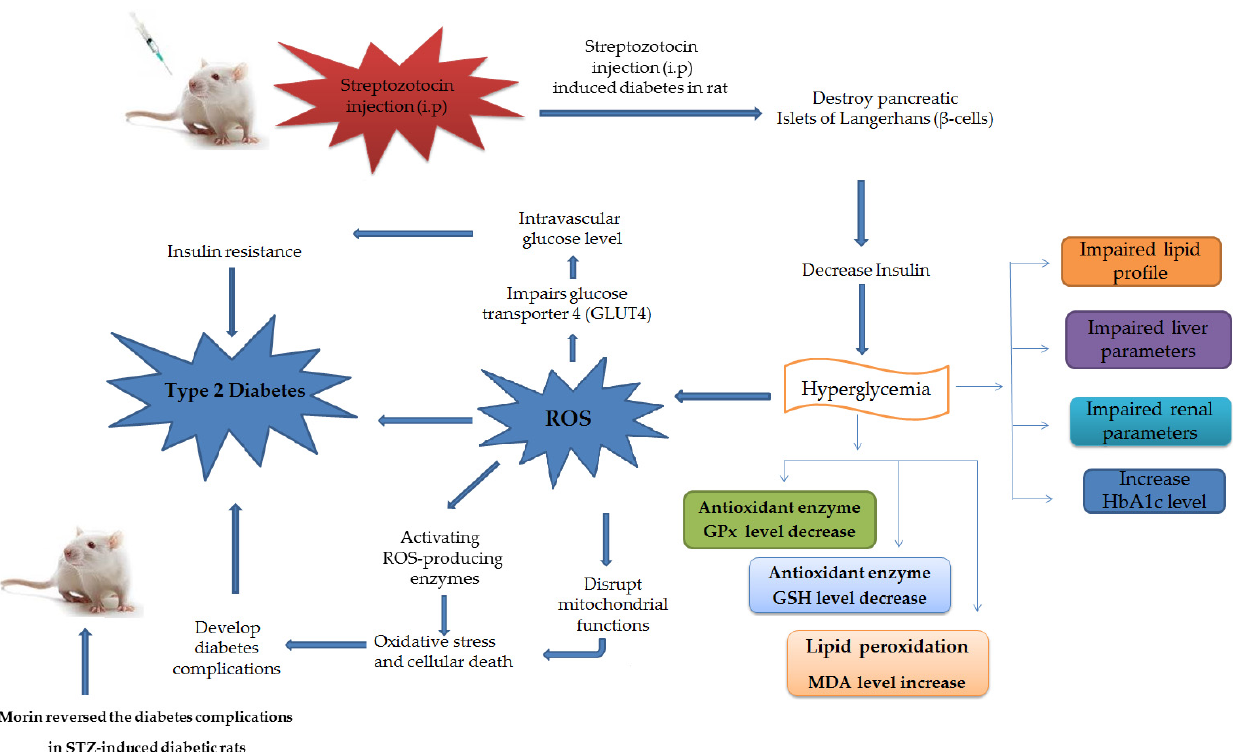
Figure 7. The potential effect of morin on streptozotocin-induced diabetic rat model.